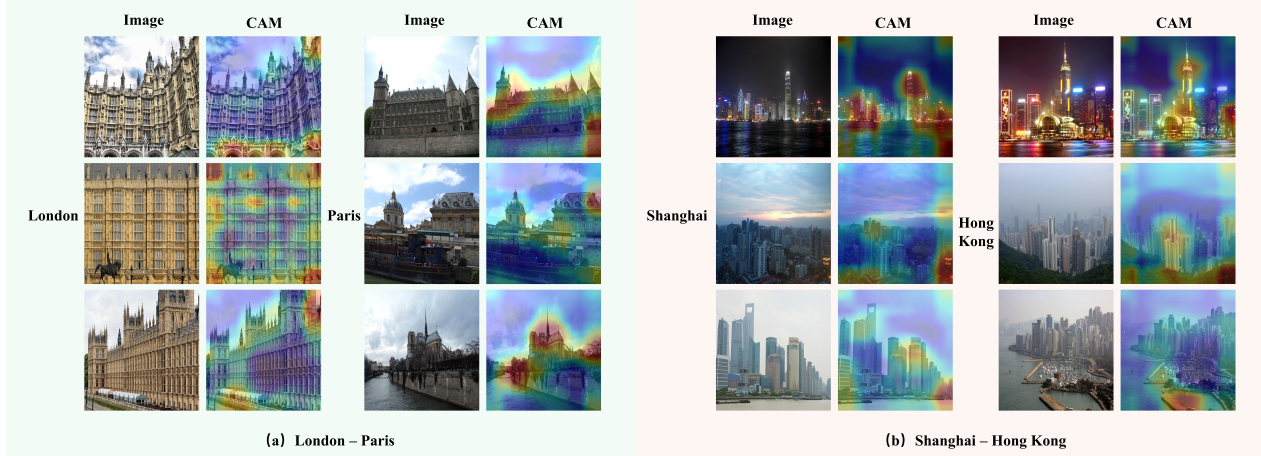
Figure 7. Analysis of the reasons for the ( a ) London–Paris and ( b ) Shanghai–Hong Kong similarity. The first column (Image) represents the source image, and the second column (CAM) represents the class activation map of layer 4. In the CAM, the more red the color, the greater the